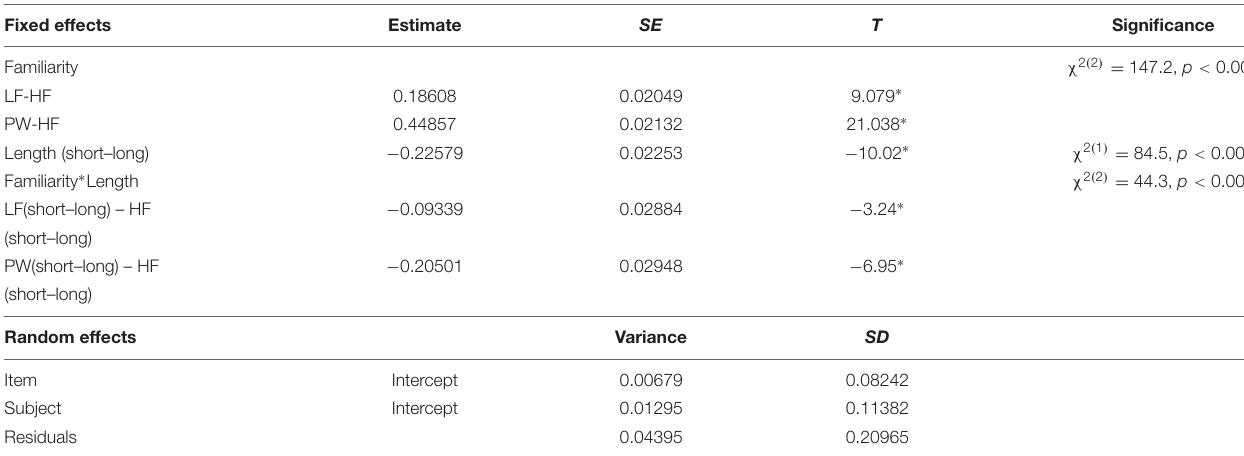
TABLE 3 | Predictors of Gaze Time/Processing